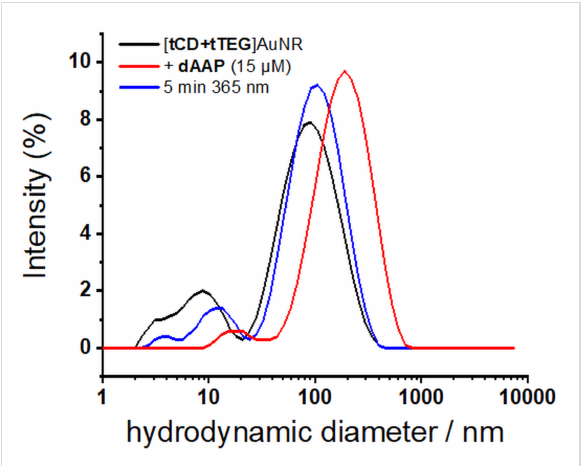
Figure 5: Reversible aggregation of [tCD+tTEG]AuNR by addition of dAAP (15 µM) monitored by dynamic light scattering.